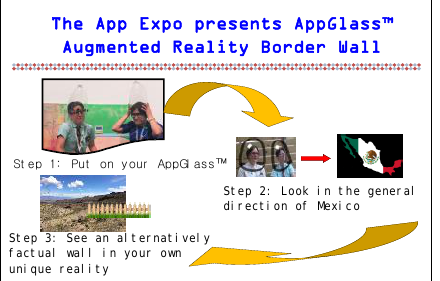
The App Expo, AppGlass ™ Augmented Reality Border Wall (2018) digital rendering for Other Border Wall Project: How to Build a